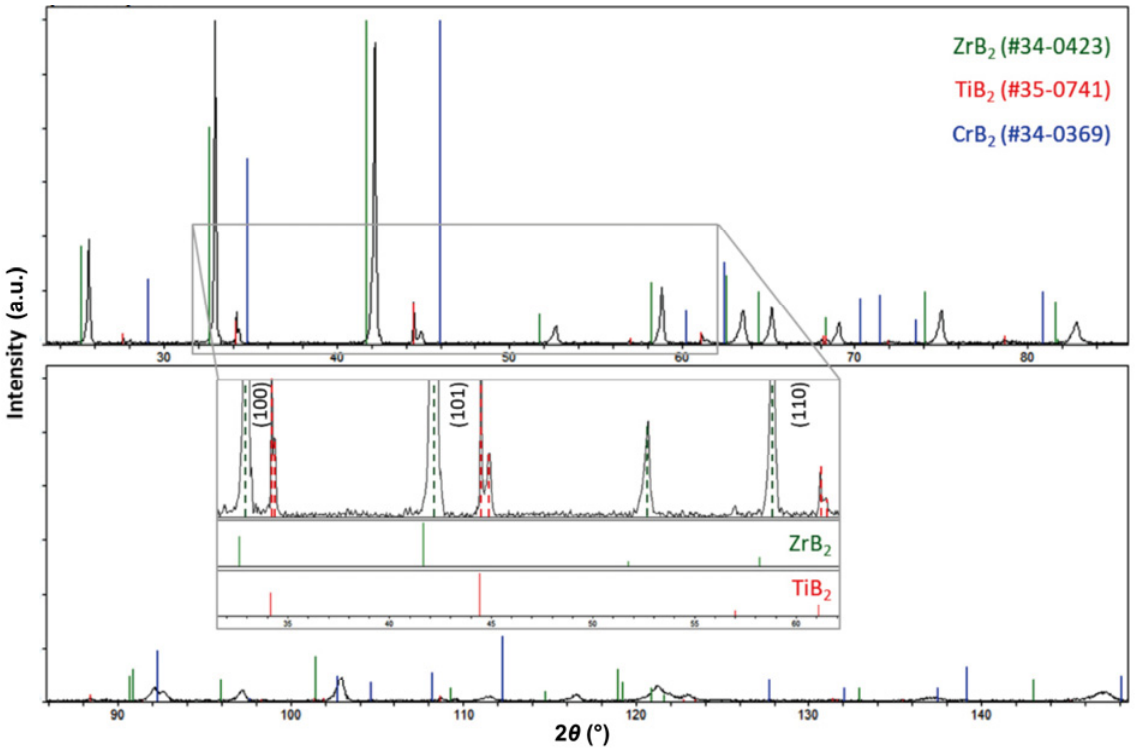
Fig. 4 XRD pattern of the sintered ZrB 2 + 30 TiB 2 + 5 CrB 2 + 5 SiC (ZTC-B) ceramic highlighting ZrB 2 peaks shift and TiB 2 peaks splitting in the